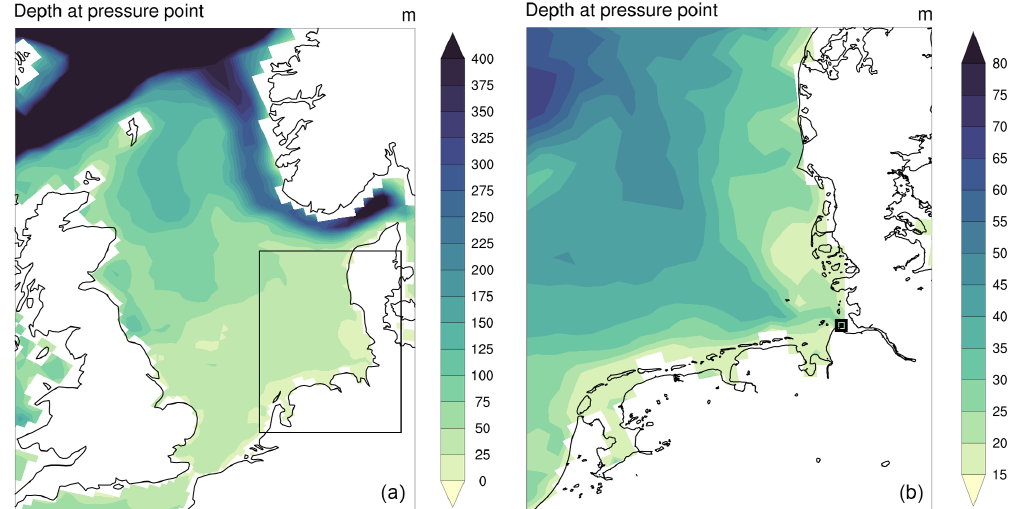
Figure 1. Bathymetry of the North Sea (a) and the German Bight ( b ; the main study location, Cuxhaven, is marked by the black square) as represented in MPIOM. The model’s land mask is shown in white and the present-day coastline is shown in